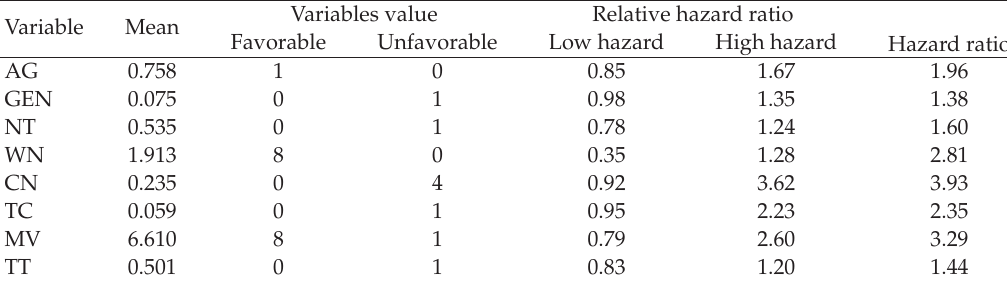
Table 3: Estimation of RHRs and HRs for assumed